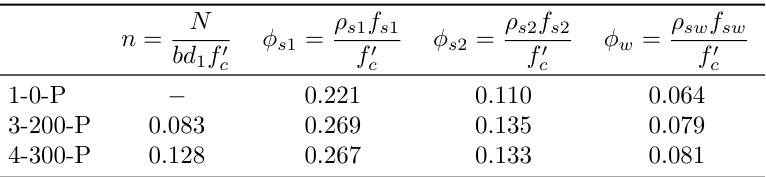
Table 2. Non-dimensional static constants.